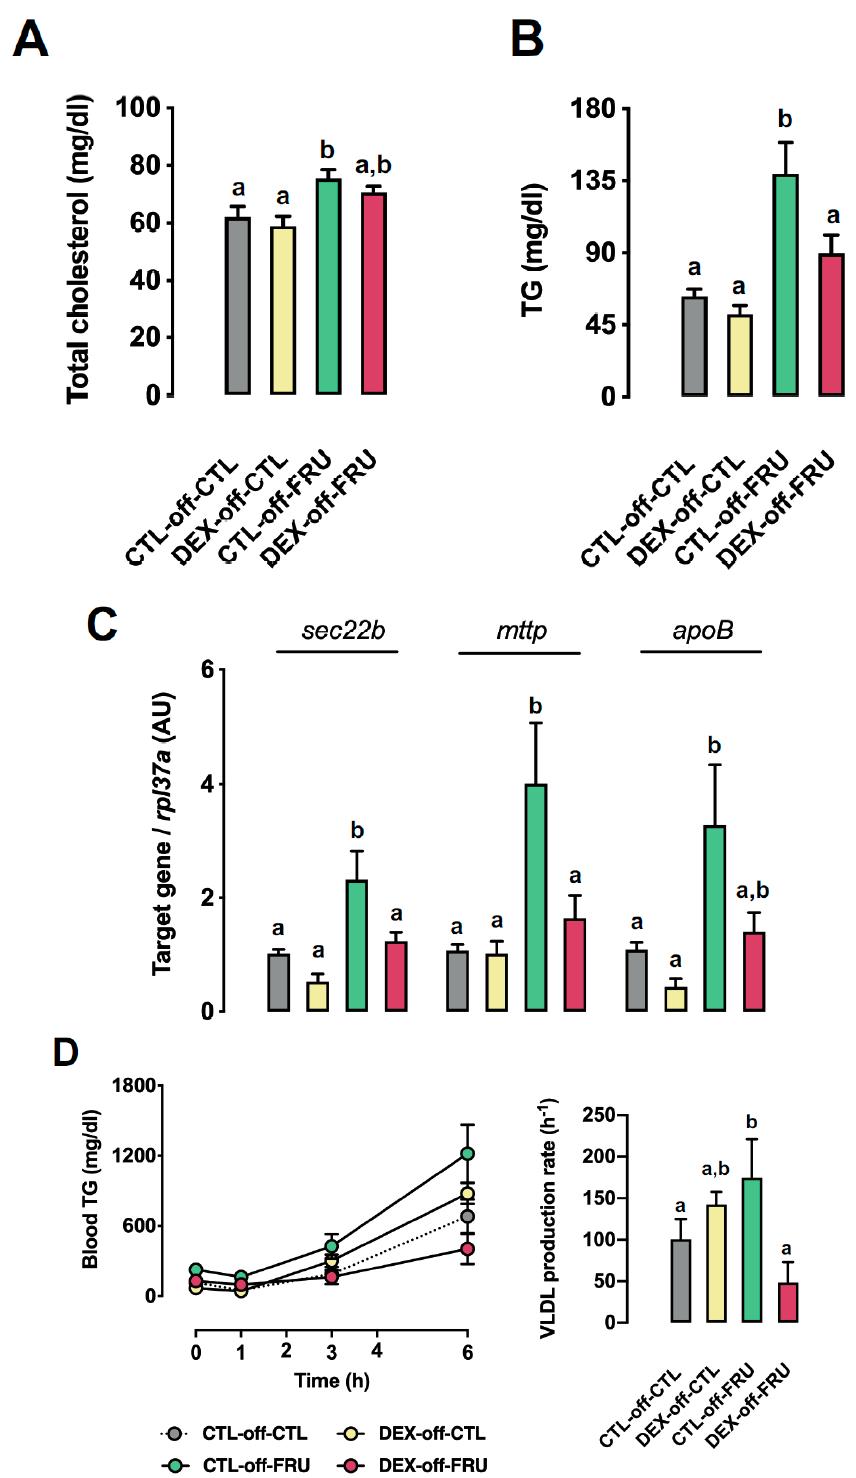
Figure 5. Effects of fructose on parameters related to very-low-density lipoprotein (VLDL) production in rats exposed to DEX in utero. ( A ) Total cholesterol and ( B ) triglyceride (TG) liver content. ( C ) Hepatic gene expression of sec22b , mttp , and apoB , as determined by qPCR. ( D ) VLDL production in CTL-off-CTL, DEX-off-CTL, CTL-off-FRU, and DEX-off-FRU rats injected with tyloxapol. The results are presented as the mean ± SE. Means with different superscript minuscule letters are significantly different. The p values are provided in Section 3. N = 6 ‒ 8.